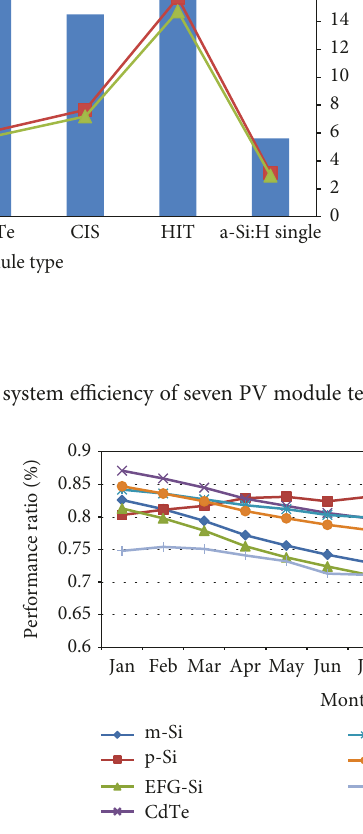
Figure 7: Monthly average performance ratio of seven PV module technologies.